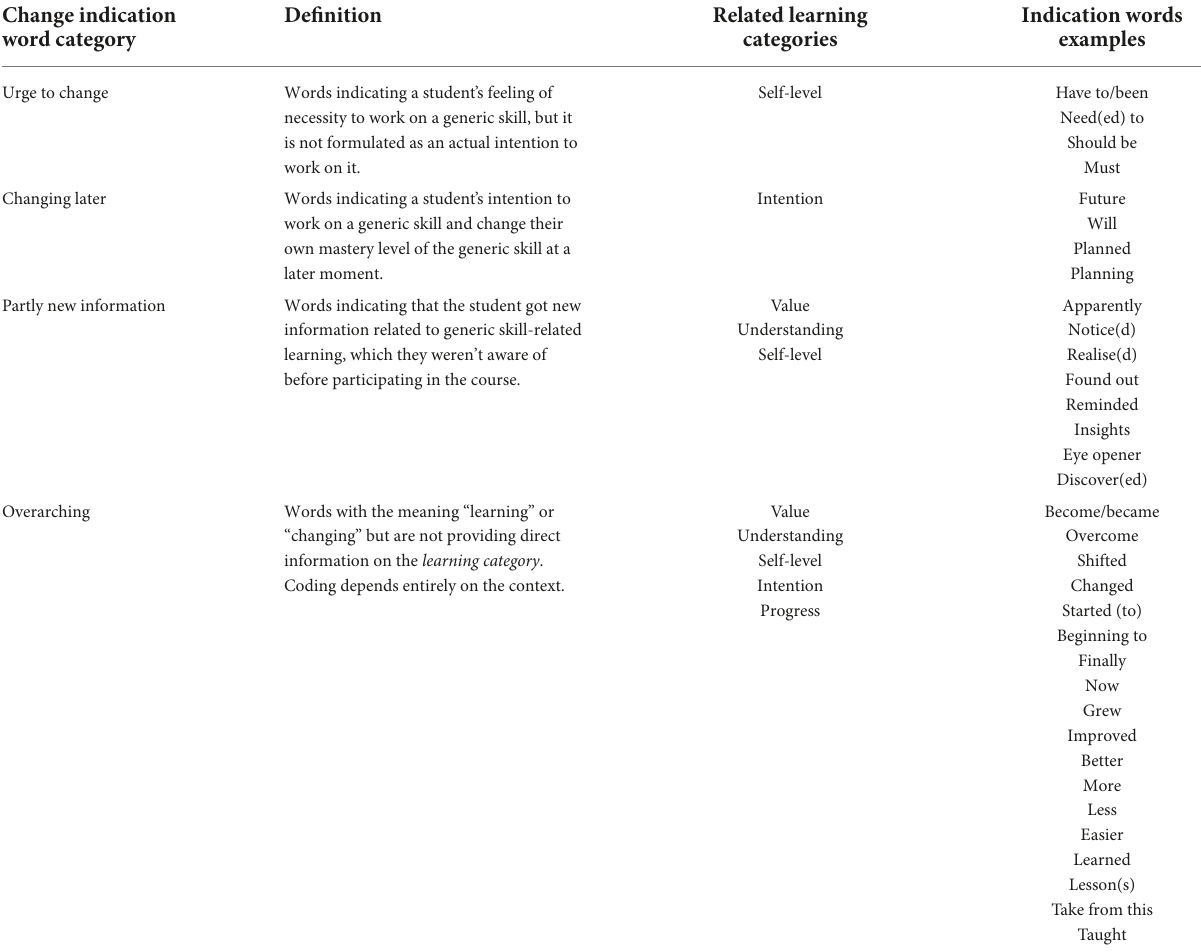
TABLE 2 Indication word categories, their definitions, related learning categories , and examples. Change indication word